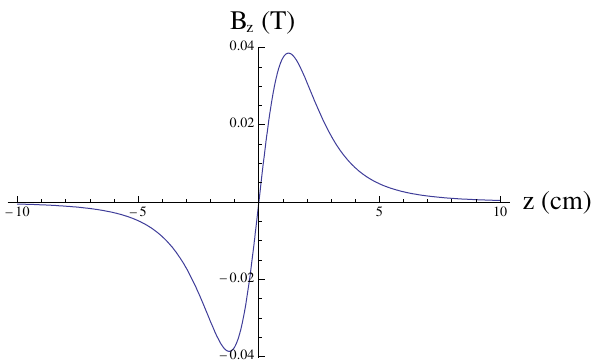
FIG. 9. (Color) The field component B (cid:2) ¼ (cid:4)= 4 , z 2 ½(cid:1)1 ; 1(cid:3) for the monopole doublet in the case that a ¼ 2 : 5 cm and g ¼ 1 Tesla - ð cm Þ 2 . The coordinate z is given in centimeters.